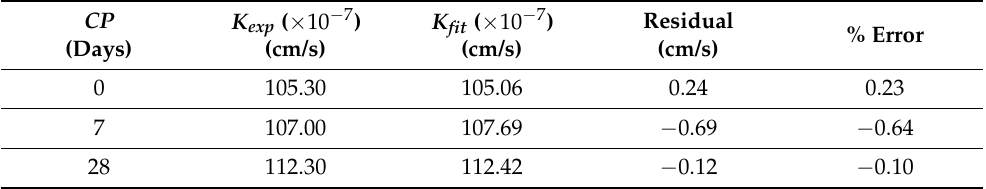
Table 9. The nonlinear equations for the hydraulic conductivity ( K fit ) of untreated clay measured after 0, 7, and 28 days of curing.